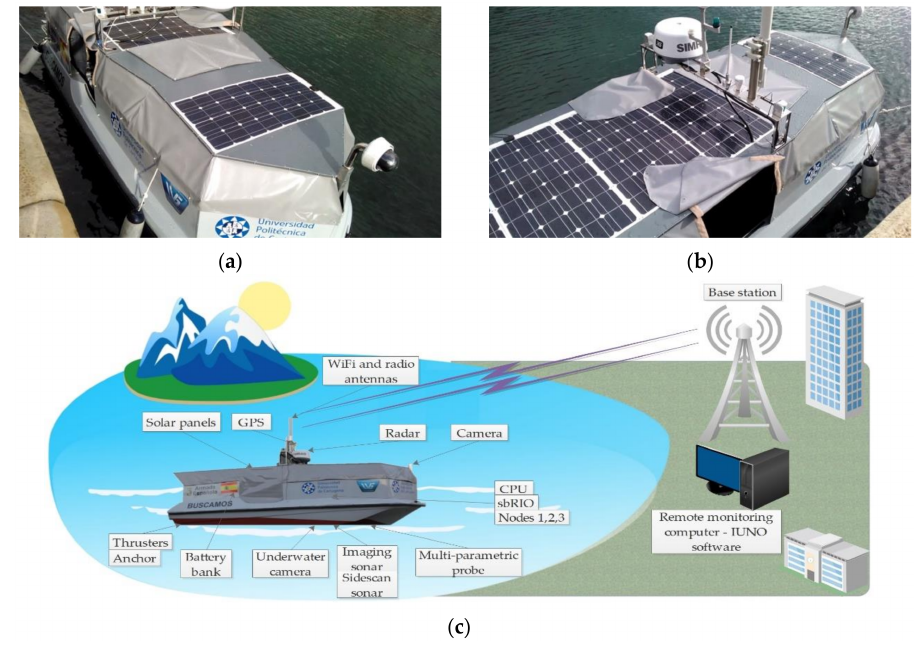
Figure 1. ( a , b ) BUSCAMOS-RobObs pictures and ( c ) general